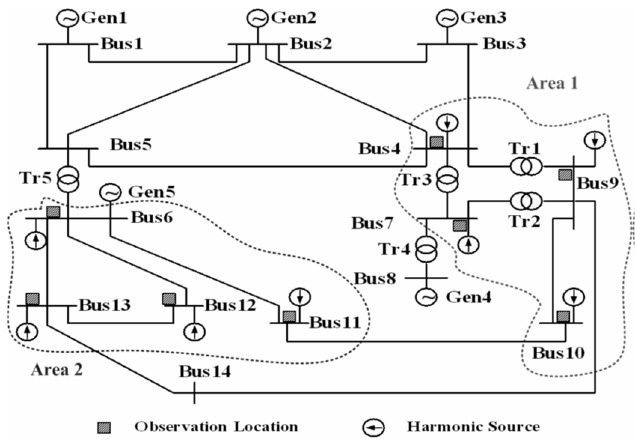
Figure 3. IEEE 14-bus system. Figure 3. IEEE 14 ‐ bus system. Table 1. Non-linear devices of 14-bus system. Table 1. Non ‐ linear devices of 14 ‐ bus system. Bus No. Bus